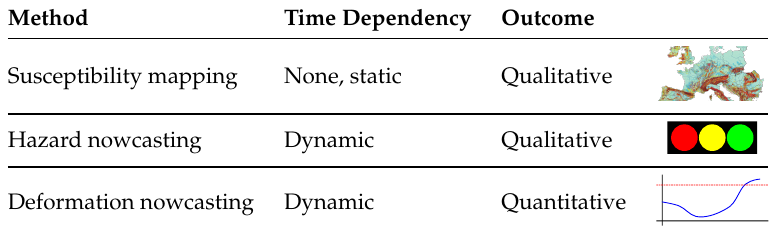
Table 3. The methods of landslide susceptibility or hazard assessment discussed, and their properties in time and type of analysis. (Map icon derived from